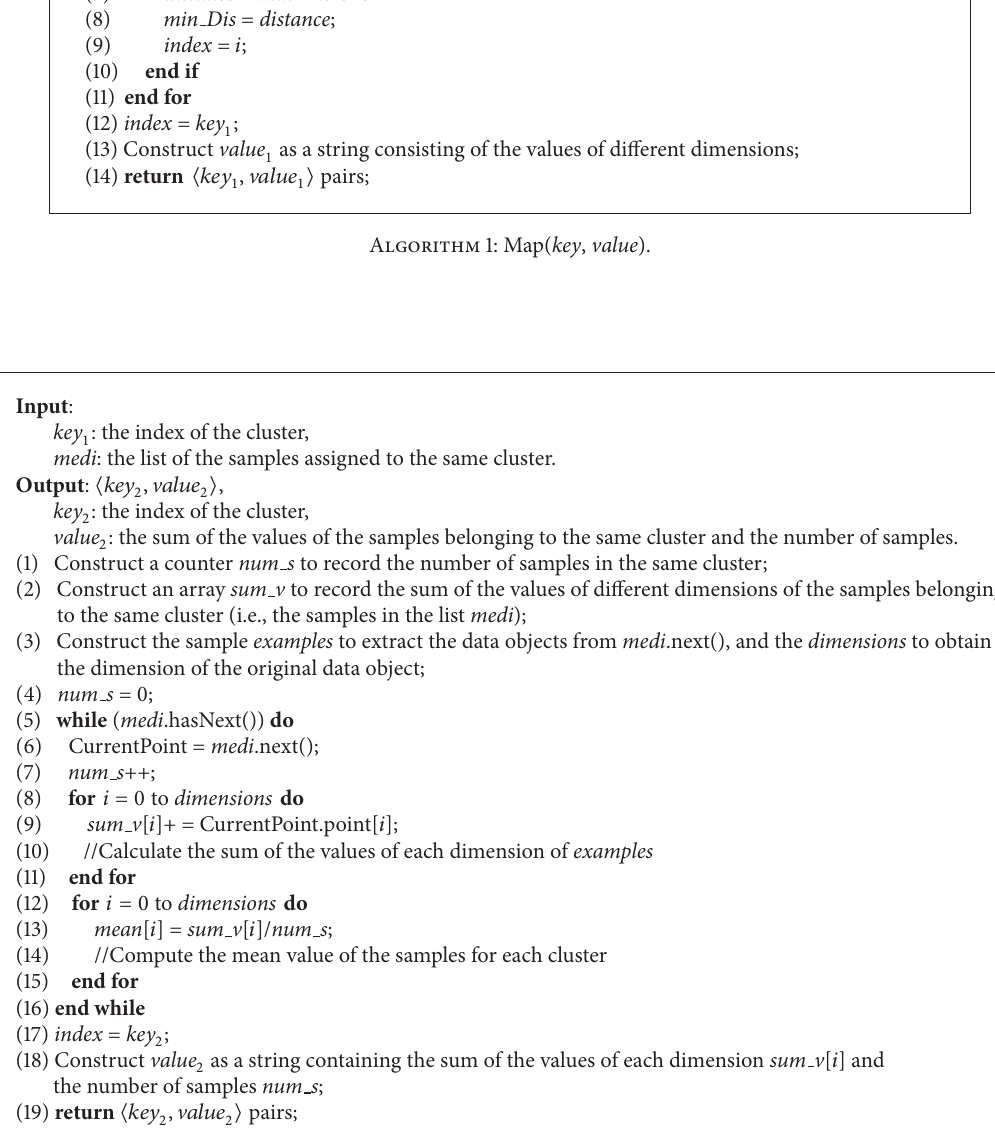
Algorithm 2: Combiner( key 1 , medi